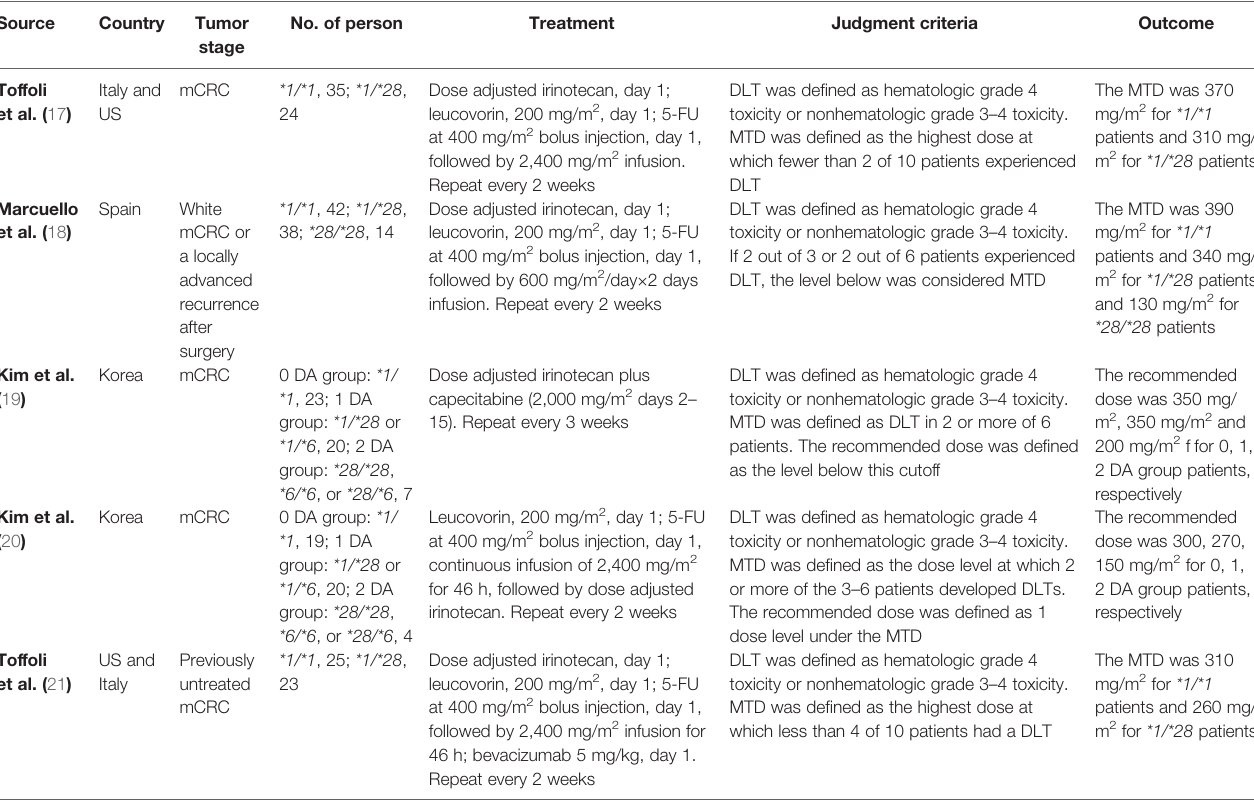
TABLE 1 | MTD of irinotecan in mCRC patients with UGT1A1 wild-type or heterozygous variant. Source